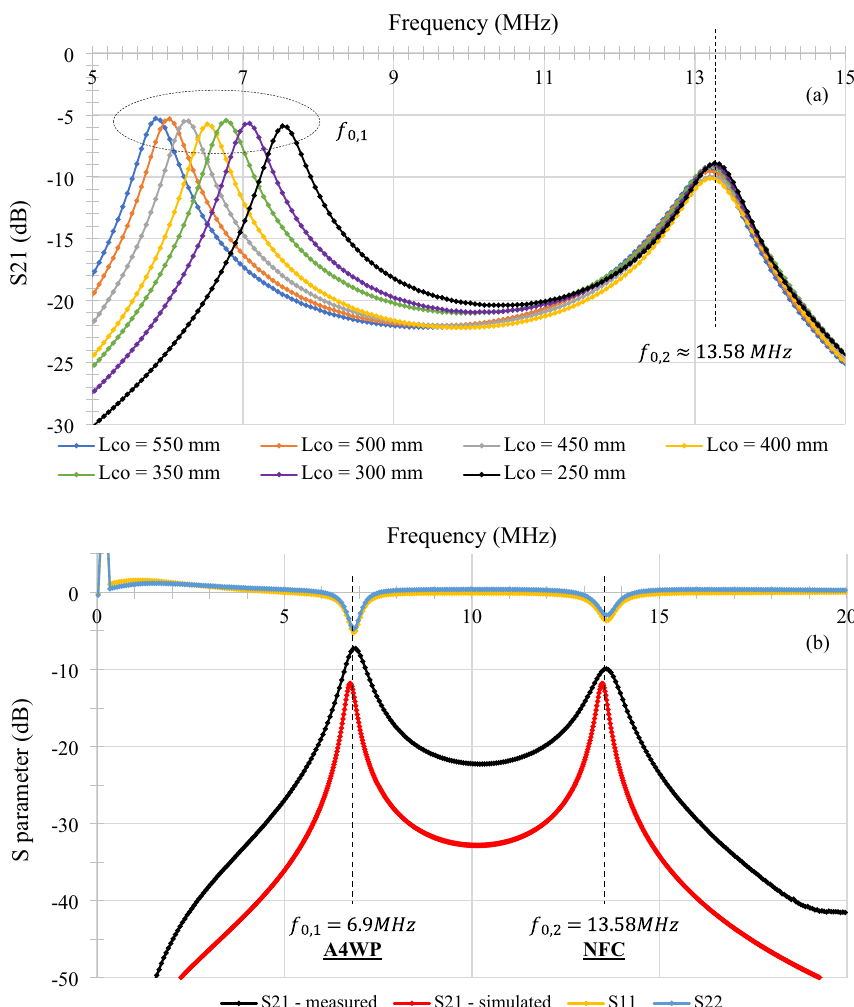
Figure 5. ( a ) Textile dual-band combiner’s measured S 21 parameter with opening length L co (mm) varying from 250 to 550 mm. ( b ) The NFC-A4WP adapted textile dual-band combiner’s measured and simulated S 21 parameter from 0 to 20 MHz. The measured S 11 and S 22 parameters. The A4WP and NFC standard frequencies are highlighted.